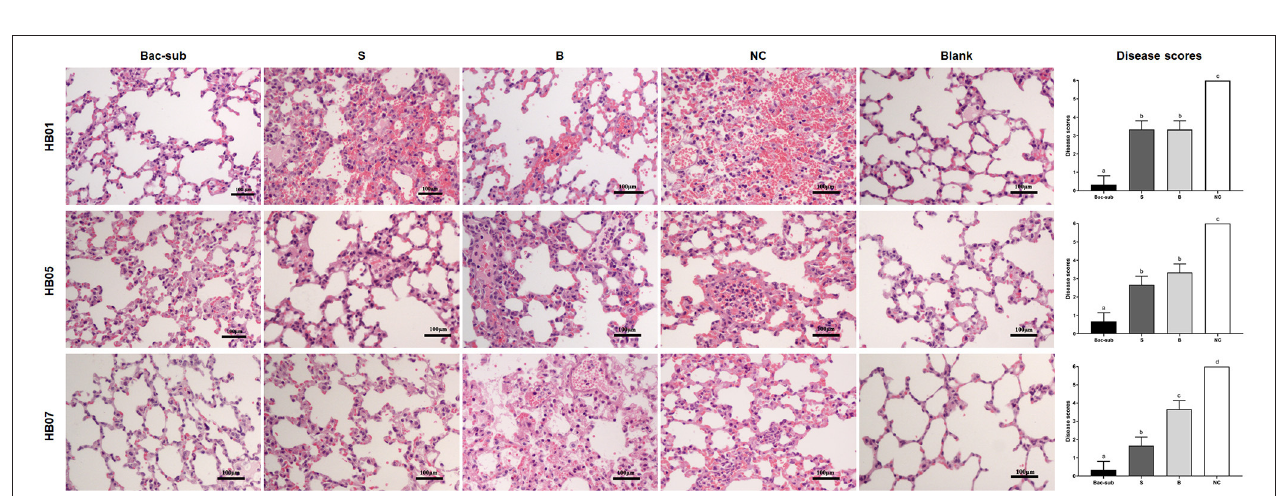
FIGURE 4 | The survival curves of mice (A1–C1) and bacterial loads in the lungs of the surviving mice (A2–C2) . Mice were vaccinated two times separately with the Bac-sub vaccine, subunit vaccine (S), bacterin (B), and PBS (NC), and then challenged with Actinobacillus pleuropneumoniae strain HB01 (A1,A2) , HB05 (B1,B2) , and HB07 (C1,C2) , respectively. The survival of mice and their lung bacterial loads (LBLs) are recorded according to Section “ Materials and Methods ”. Survival rates and LBLs were compared using a one-way ANOVA. * p < 0.05, ** p < 0.01, *** p < 0.005, **** p < 0.001.